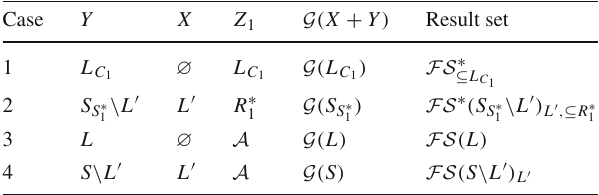
Table 1 Special results of FS ∗ ( Y ) X , ⊆ Z